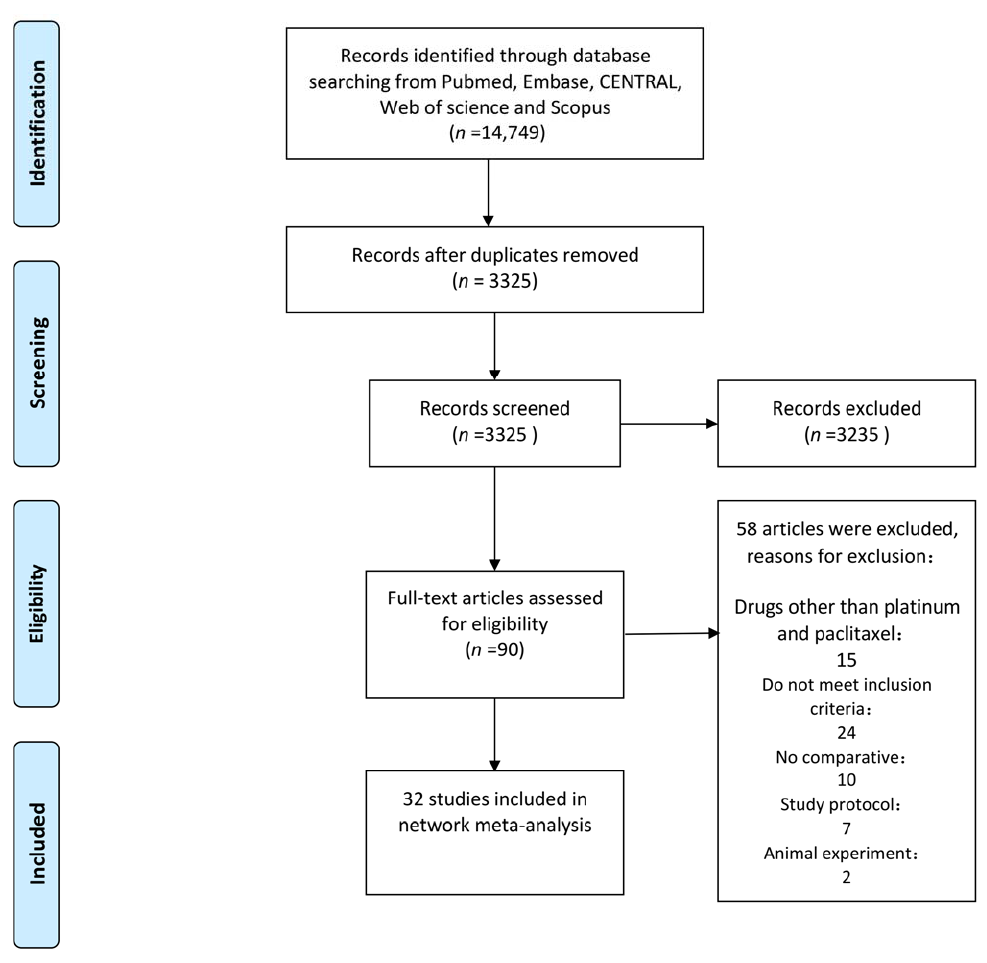
Figure 1. Flow diagram of study selection.